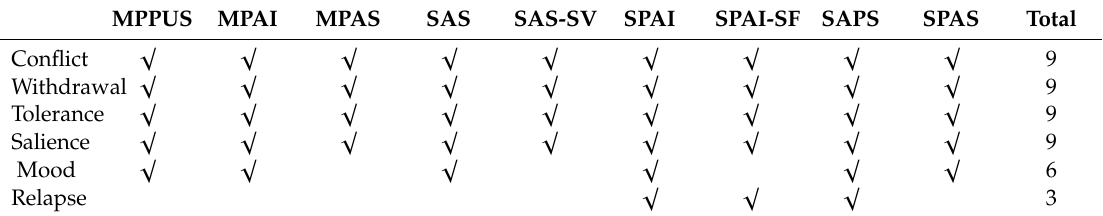
Table 2. Comparison of major validated scale variables based on Gri ffi ths’ component model.